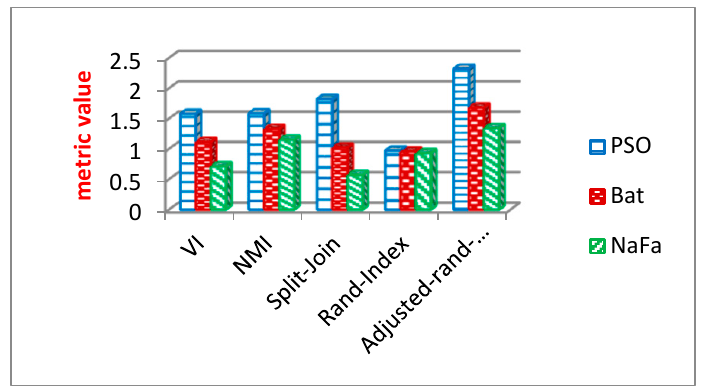
Figure 21. Average of the normalized values for each metric on all datasets .